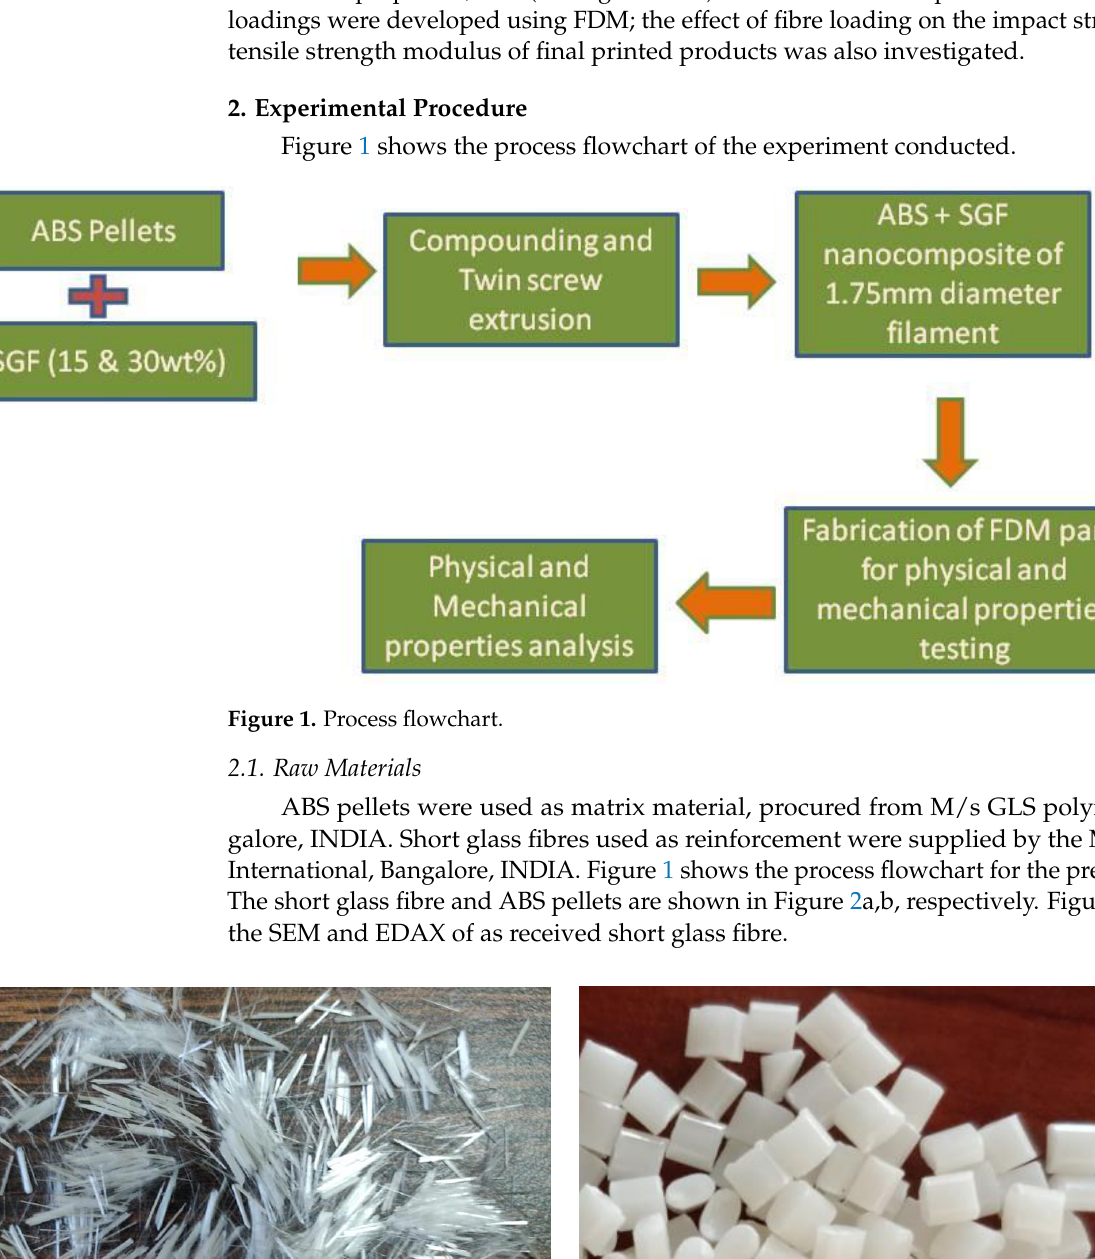
Figure 2. Photograph of as received ( a ) short glass fibre and ( b ) ABS pellets.